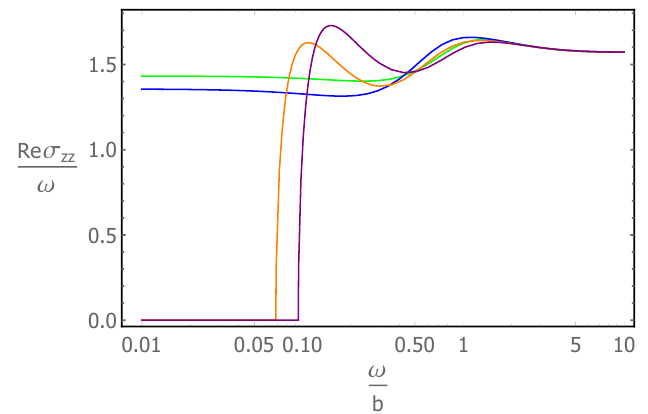
Figure 3 . The real part of longitudinal conductivity as a function of the frequency !=b for di(cid:11)erent values of M=b = 0 : 941 (green), 0 : 983 (blue), 0 : 987 (orange), 1 : 019 (purple) in the topological phase and the insulating phase.